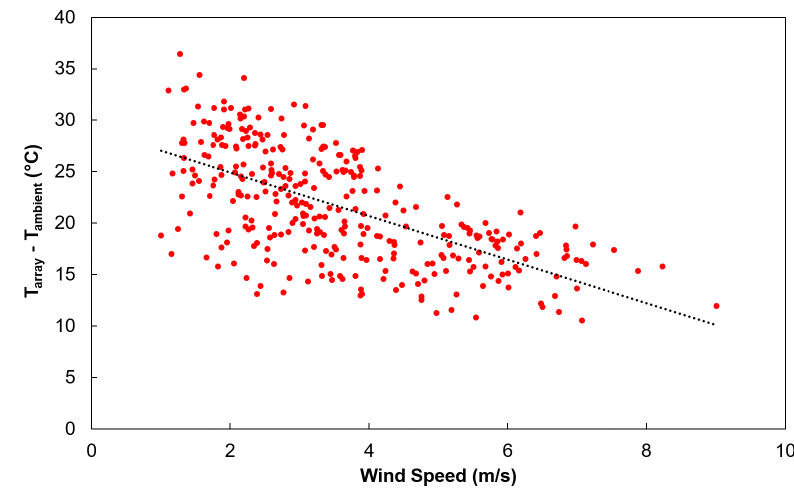
Figure 7. Wind speed vs. temperature difference between ambient and array.